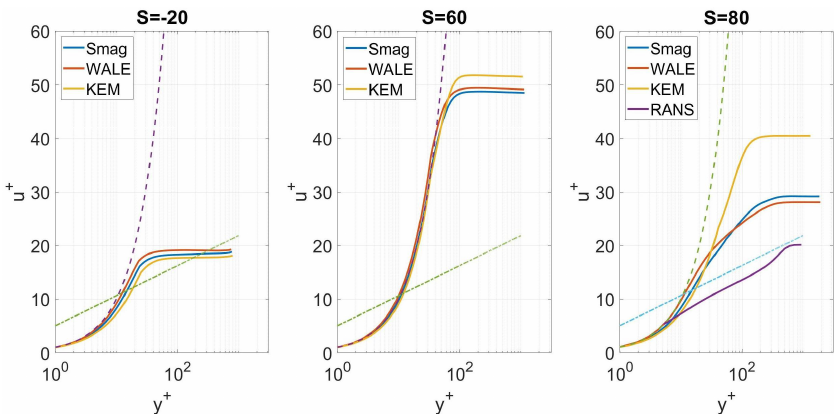
Figure 4. Influence of the SGS closure models: velocity